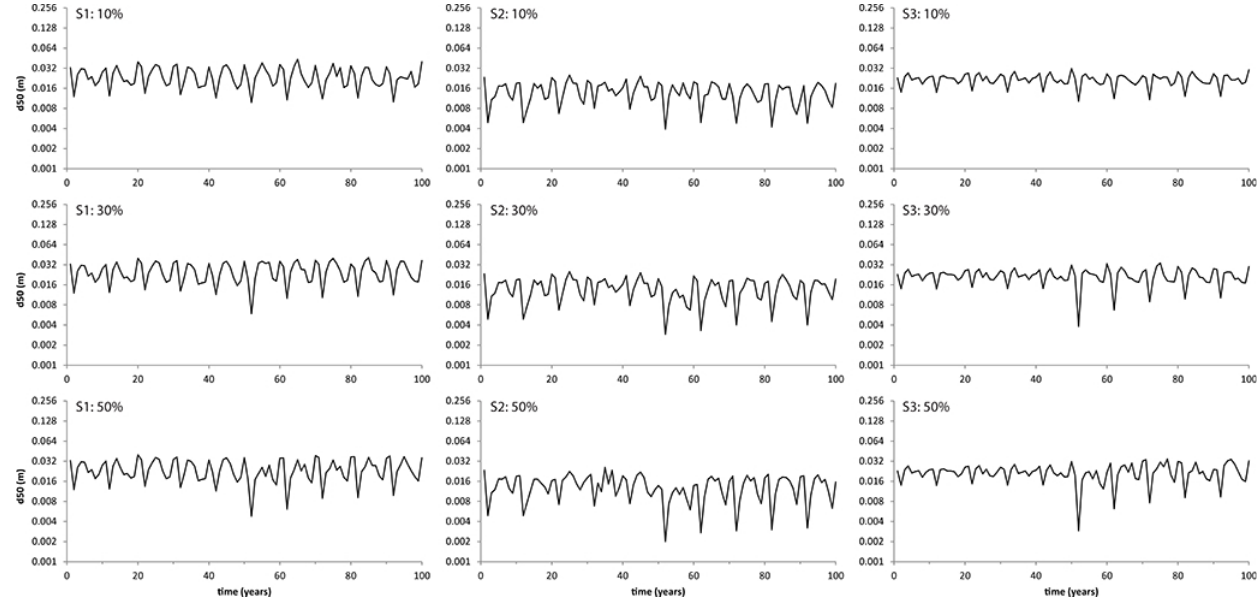
Figure 7. Grain size changes after rainfall changes for S1, 2 and 3 with 10, 30 and 50% increases in precipitation magnitude after 50 simulated years. Median grain sizes were calculated as per the method outlined in Fig. 6.